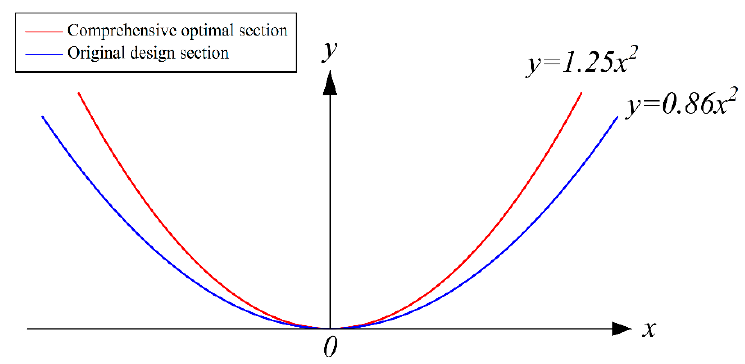
Figure 7. Two types of channel section forms.